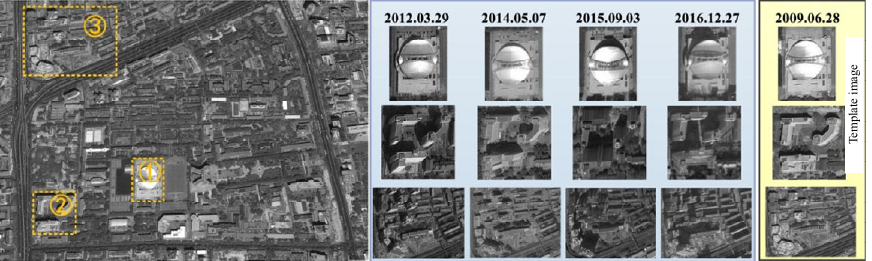
Fig. 6 DBA image examples of the BIT at different